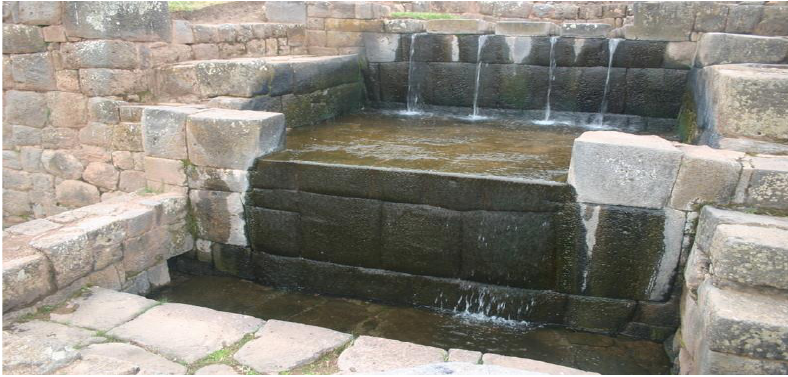
Figure 67. Waterfall structure supplied from the Figure 66 channel. Photo by author.